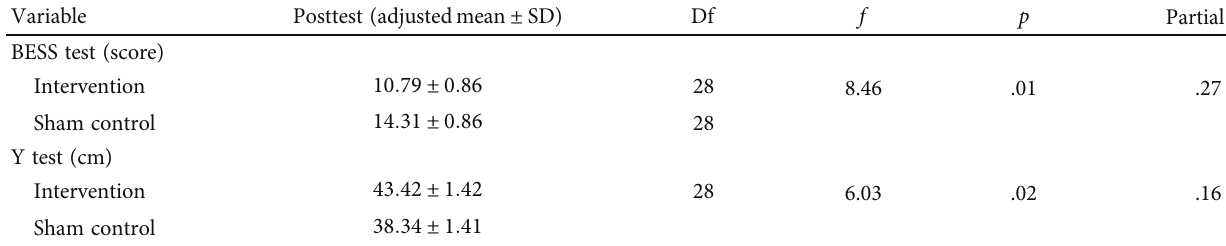
Table 3: The result of ANCOVA test.